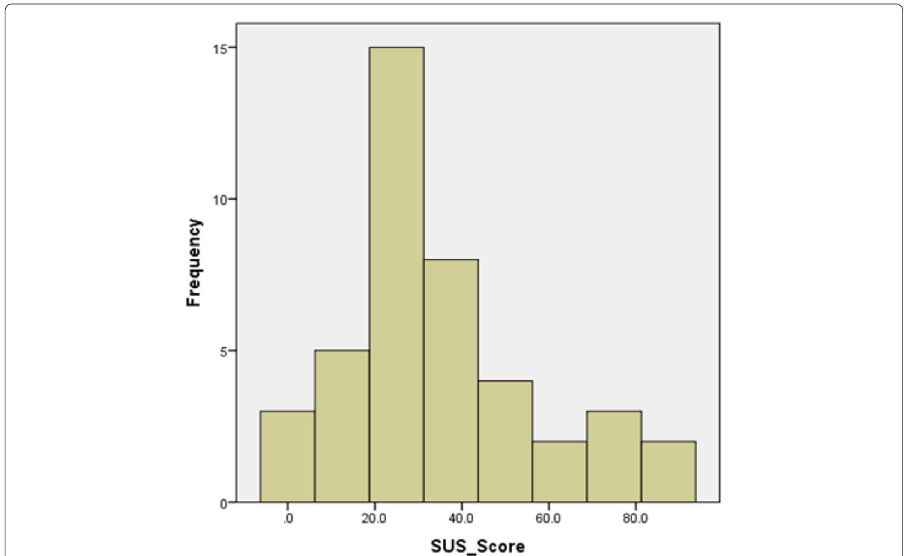
Fig. 37 Histogram of the SUS scores of the ESHL